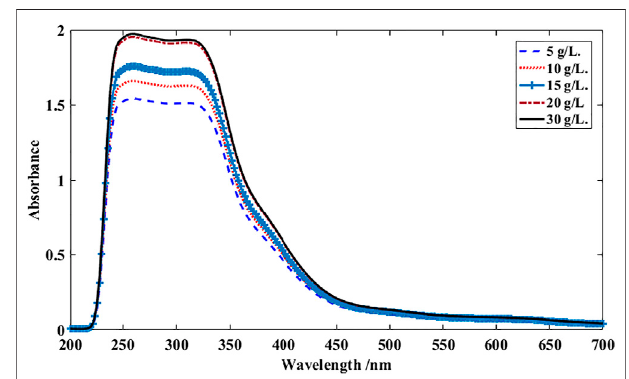
Frontiers in Bioengineering and Biotechnology |